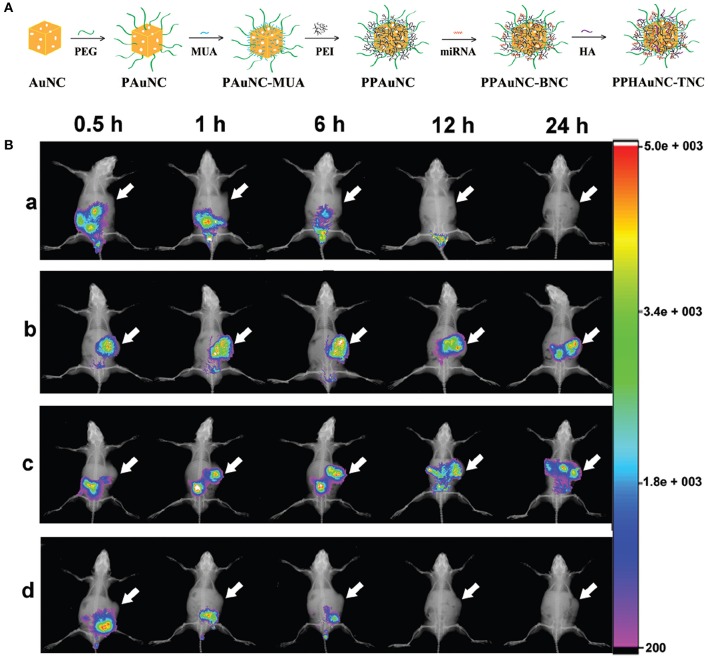
(A) Formation of PPHAuNC-TNC. (B)
in vivo biodistribution of differently-sized PPHAuNCs-TNCs. After intravenous injection with (a) naked Cy5.5-miRNAs (control group), (b) PPHAuNCs-30-TNCs, (c) PPHAuNCs-50-TNCs, and (d) PPHAuNCs-70-TNCs.